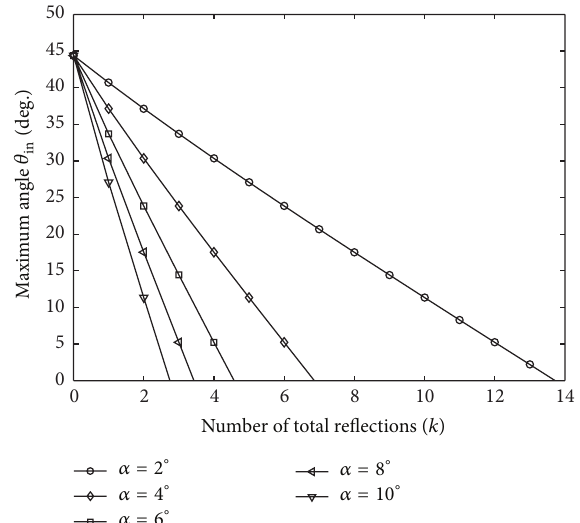
Figure 7: Maximum angle of 𝜃 1 with respect to the number of total reflections on the body and the end surface (to prevent reflection) for different CTPC angles.